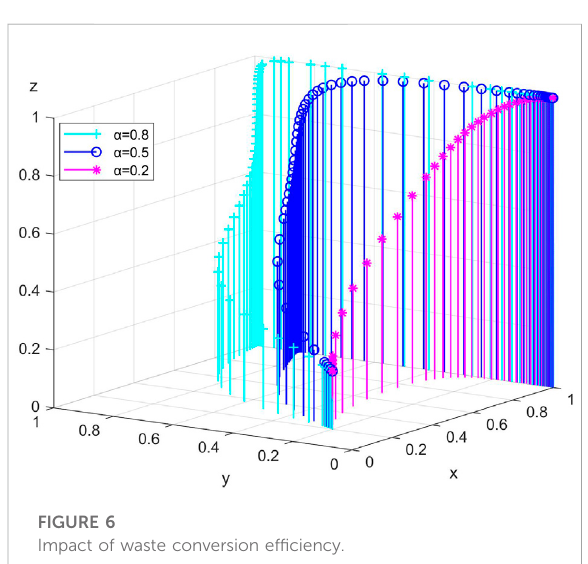
FIGURE 6 Impact of waste conversion ef fi